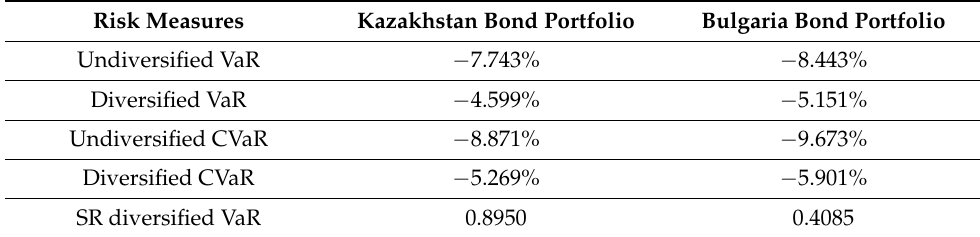
Table 7. Risk measures of Kazakhstan and Bulgarian bond portfolios. Risk